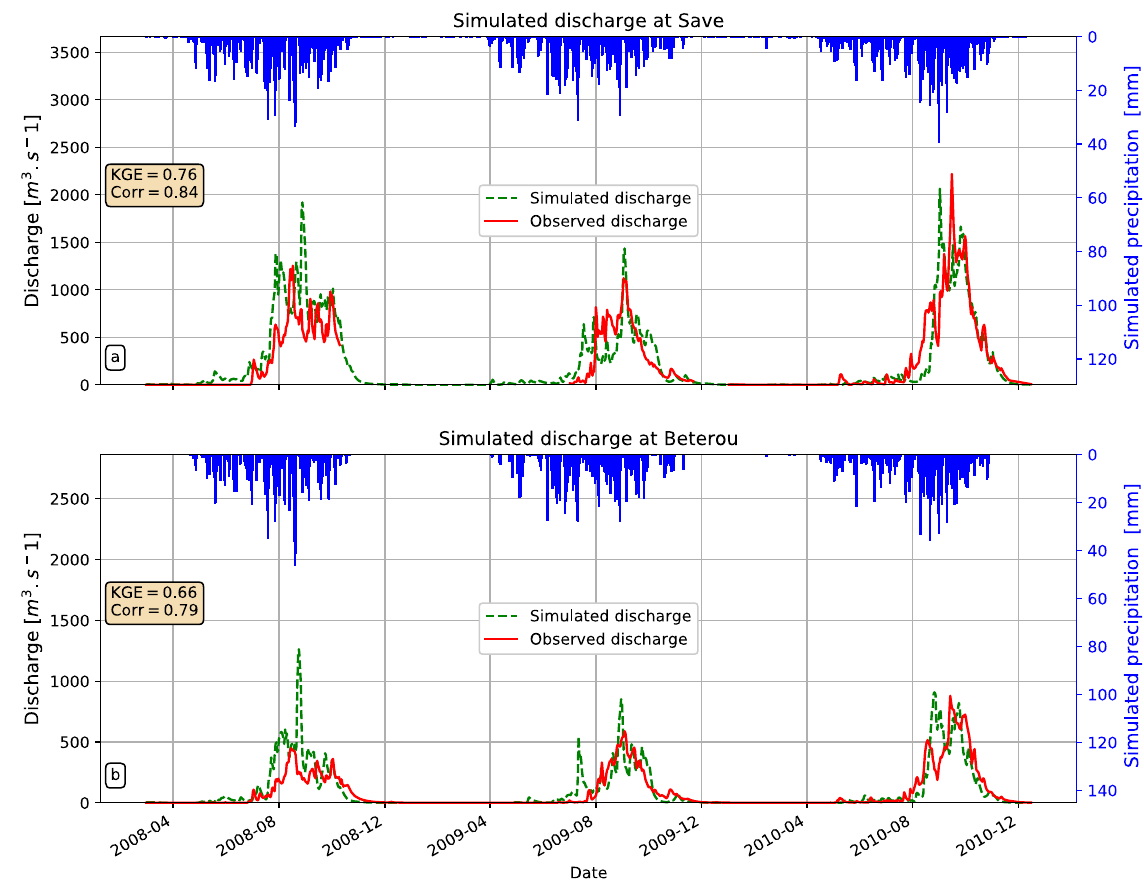
Figure 9. Observed and simulated (fully coupled WRF-Hydro) hydrographs and derived precipitation from WRF-Hydro: ( a ) full year at Savè, and ( b ) at Bétérou (Savè’s inner catchment).